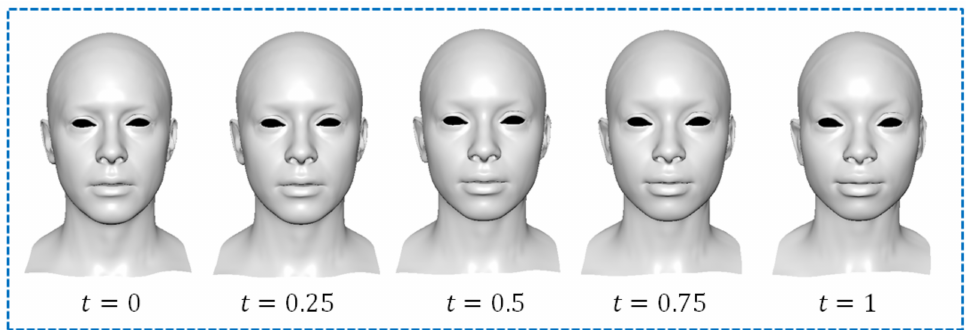
Figure 9. Facial blendshapes created by using Equation (29) with w 1 = 0.7, w 2 = 0.2, and w 3 = 0.1.